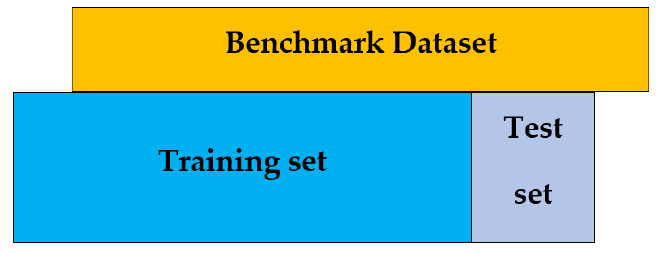
Figure 12. Independent test. Table 8. Results of independent test based on the Random Forest.